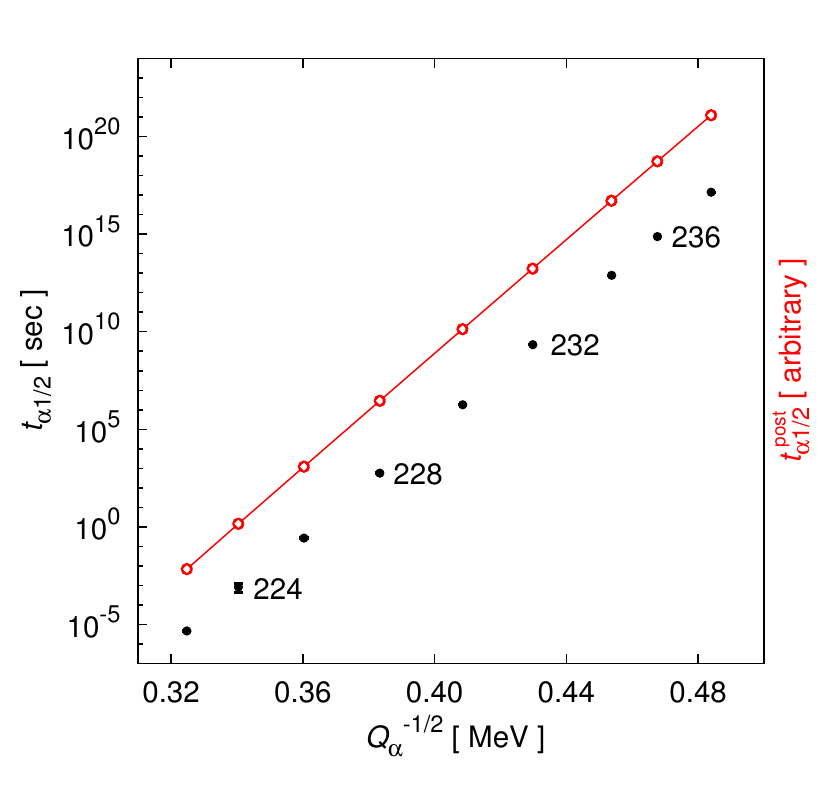
Figure 3. Half-lives, t 1 / 2 , of Uranium isotopes as a function of the inverse of the square root of Q α . The filled black points are the experimental data. The red open circles are the calculated half-lives from P dd with the post-formation hypothesis of d - d pair tunneling. For the deuteron penetrability, the Whittaker function in Equation (8) was used. P dd is the product of two deuterons’